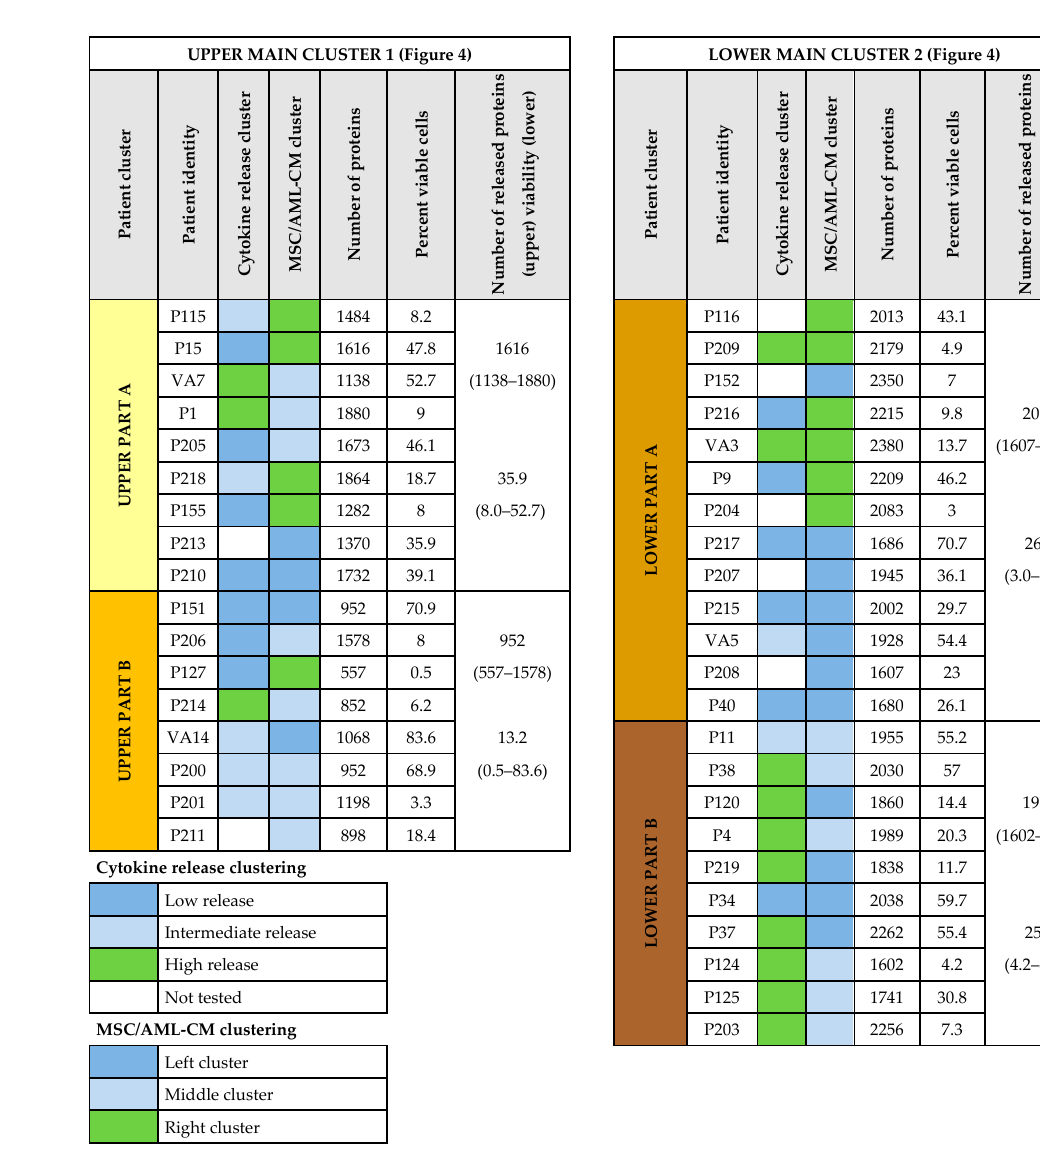
Figure 6. Identification of AML patient subsets by hierarchical clustering analysis of constitutive leukemic cell protein release. The AML cells were derived from 40 patients, and the cells were cultured alone for 48 h in serum-free medium before supernatants were analyzed. The number of quantified proteins varied from 557 to 2380 proteins (average 1699 proteins), and the proteomic analysis was based on the 1770 proteins detected in 50% or more of the AML-CM samples. This clustering analysis is presented in Figure 4; two main clusters each with two subclusters were identified (left and right part, respectively, of the present Figure 6), and the patients are listed from the upper part to the bottom of the present figure according to the results from this clustering analysis (patient identity columns). For 33 patients we also analyzed their release of 19 selected soluble mediators for AML cells cultured alone using antibody-based methodology (Figure S3); a hierarchical clustering analysis based on these mediator levels classified the patients into three main subsets with generally low, intermediate and high constitutive mediator release (see upper right). The column Cytokine release cluster refers to this classification, and the color codes are explained in the lower left part of the figure. Finally, we also did a hierarchical clustering analysis based on the protein release profile of all 40 patients when MSCs were cultured with AML-CM for all 40 patients (Figure S4). The subclusters/subclassification of patients based on this last analysis is summarized in the column referred to as MSC/AML-CM cluster (color code explanation, see lower left). The right part of the figure presents the number of quantified proteins and the number of viable AML cells after 48 h of in vitro culture for each patient sample. The median and range of quantified proteins/viability for each of the four patient subsets are presented to the right in each part of the